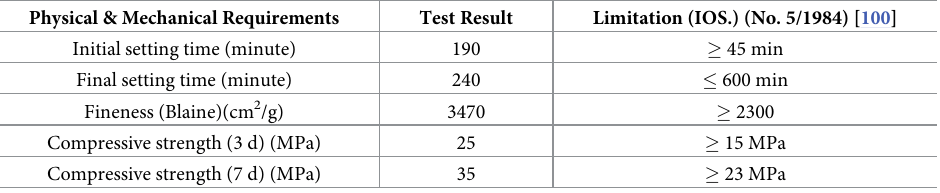
After the PET aggregate was prepared, it was evaluated in grading by sieve analysis, as illus- trated in Table 5. The physical and mechanical characteristics of the PET material are shown in Table 6 as provided by the Light Plastic Factory [96]. Due to the plastic texture and the plas- tic particle types, which are often flaky, angular, and irregular particles, the sieve analysis of PET aggregate does not conform to that of natural sand grading, as the fine natural aggregate is typically composed of spherical and granular particles. Used in this test program were unidirectional CFRP sheets (SikaWrap-300C) [97] with fibers directed along the longitudinal axis. The CFRP sheet characteristics depend on the speci- fications offered by the supplier, Sika Company, and are shown in Table 7. Epoxy resins are generally utilized to bond CFRP to concrete. The adhesive material Sikadur-330 [98] was used in this test program. Five CFRP coupons with an average dimension of 15 mm × 250 mm and Table 2. The mechanical and physical characteristics of ordinary Portland cement � .